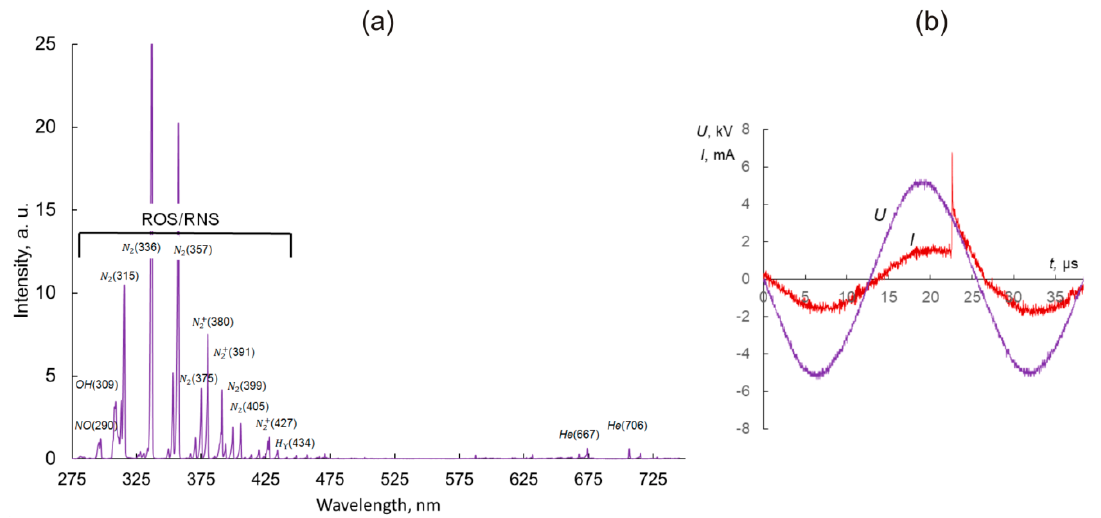
Figure 1. Characterization of the cold atmospheric plasma (CAP) setup. ( a ) Optical emission spectroscopy (OES) spectrum of the CAP in helium, v = 6 L / min, U = 4.9 kV. ( b ) Typical discharge voltage, frequency, and wave form for the CAP device for U = 4.9 kV.